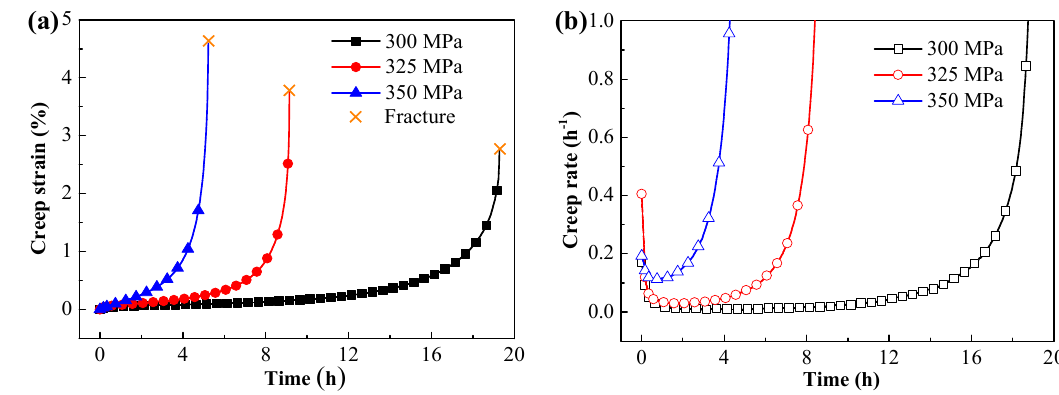
Figure 3. Creep deformation behaviors of AA7050 during creep aging tensile tests under 165 °C and different stress levels: ( a ) creep strain curves; and, ( b ) creep rate curves.